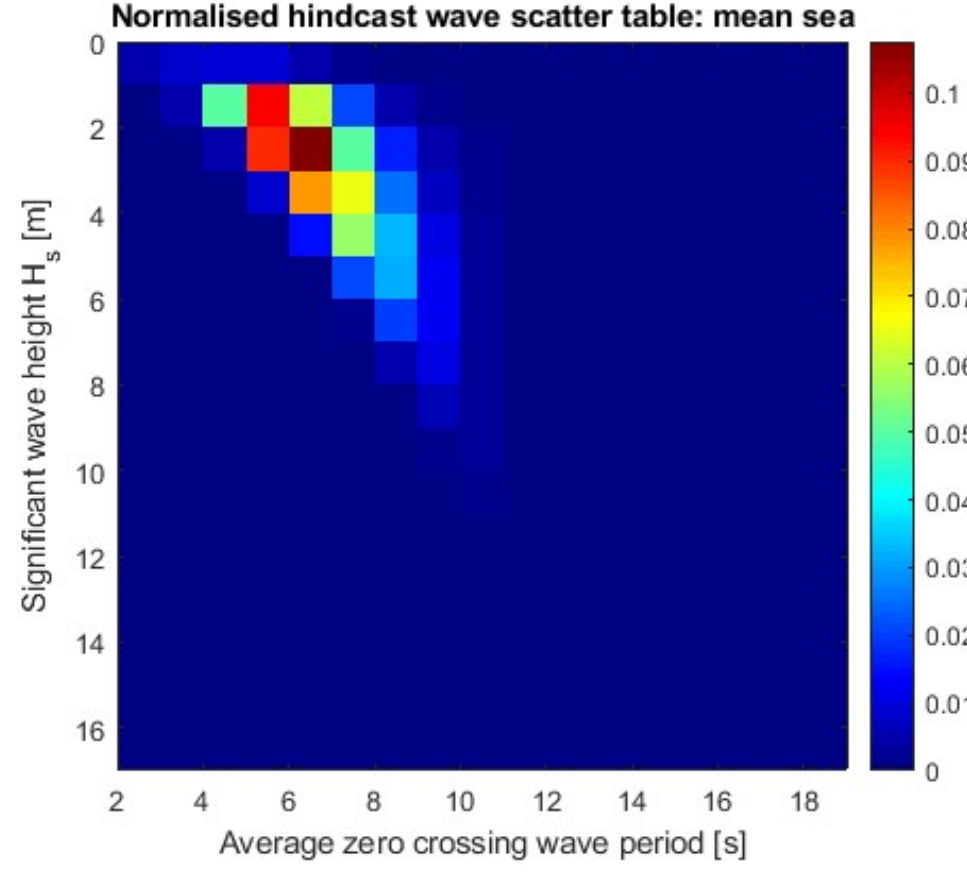
Figure 4. Hindcast WST for mean sea (sea area S—full year).